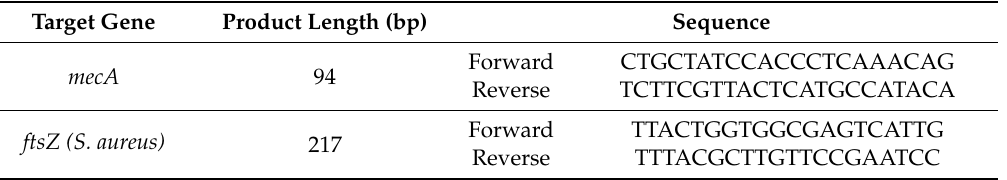
Table 4. Primer sequences used for qPCR in the present